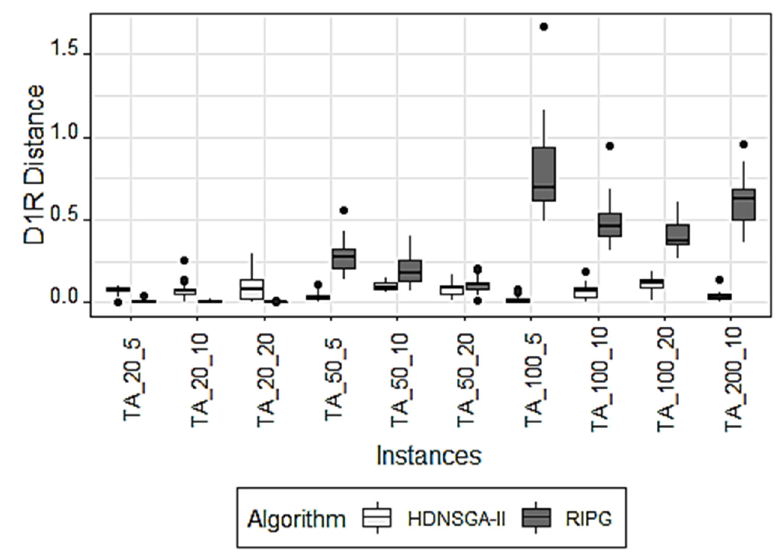
Figure 5. Comparison of the D1R distance evolution with HDNSGA-II and RIPG in each type of instance.